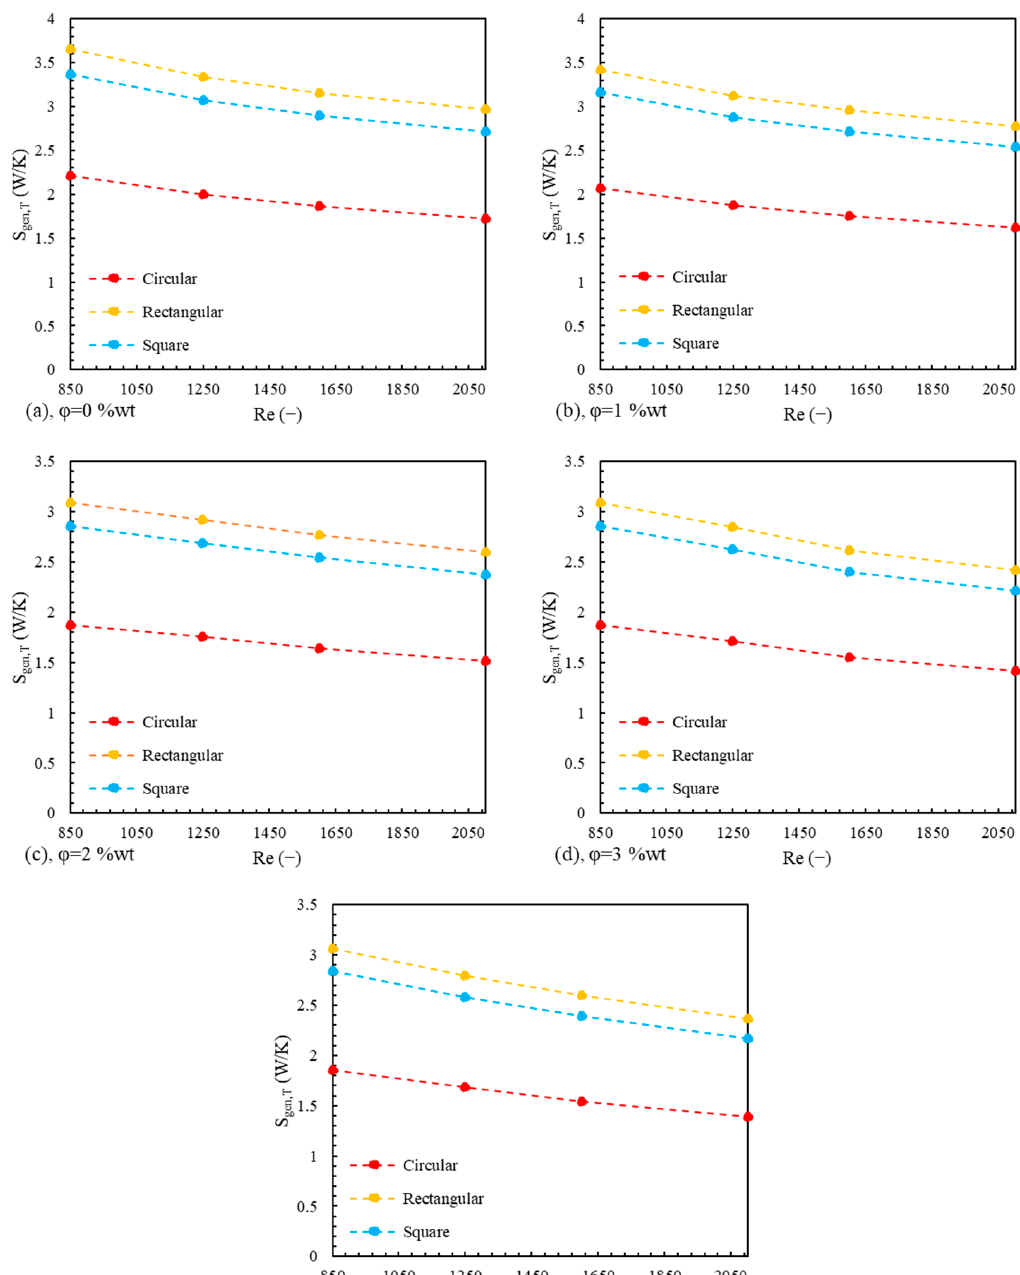
Figure 13. Total entropy generation of all cross-sections in a range of Re numbers for ( a ) water, ( b ) nanofluid with 1% concentration, ( c ) nanofluid with 2% concentration, ( d ) nanofluid with 3% concentration, and ( e ) nanofluid with 4% concentration.